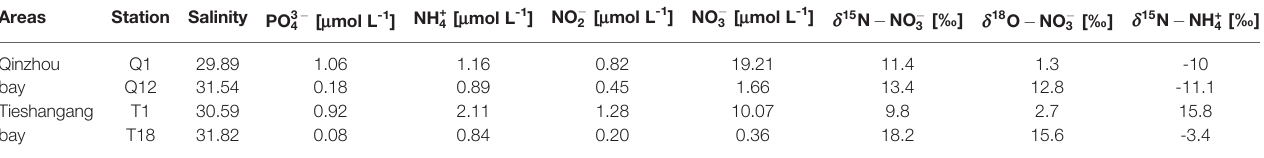
TABLE 1 | Endmember parameters of Qinzhou Bay and Tieshangang Bay, including salinity, nutrient concentrations and nitrate dual isotopes, used in the two- endmember mixing model in equation (5 – 7) .